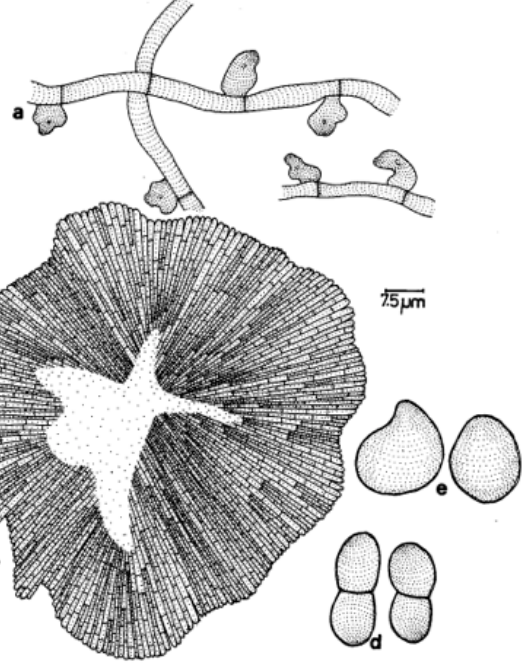
Figure 148. Asterina indica a - Appressorium; b - Thyriothecium; c - Ascus; d -